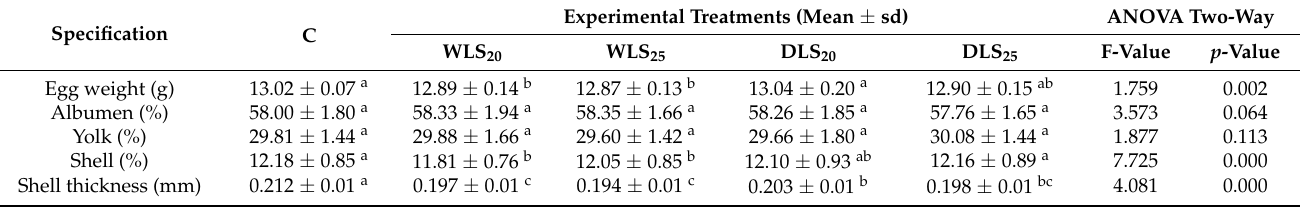
sd, standard deviation; a–c , different superscript letters in the same row are significant differences ( p < 0.05). C, control group, without lupine; WLS 20 , experimental diet with 200 g/kg whole lupine seeds; WLS 25 , experimental diet with 250 g/kg whole lupine seeds; DLS 20 , experimental diet with 200 g/kg dehulled lupine seeds; DLS 25 , experimental diet with 250 g/kg dehulled lupine